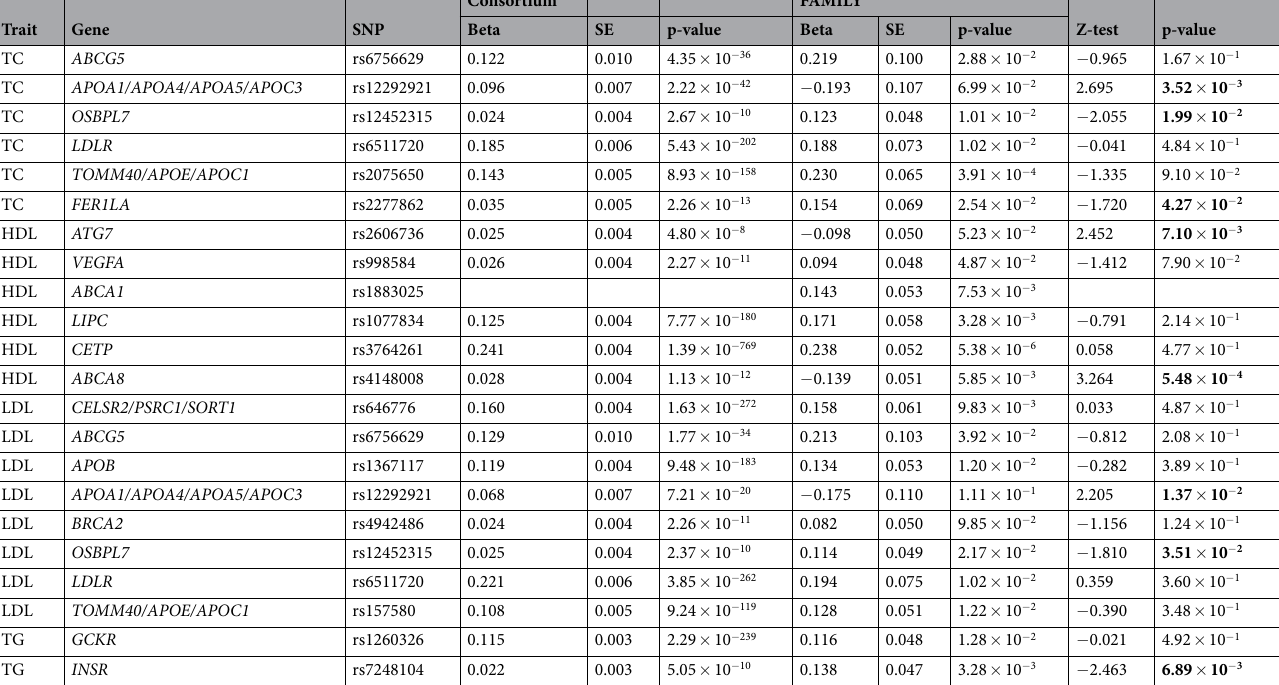
Table 4. Comparison of the statistically nominal significant SNP effects between children from FAMILY and adults from the Global Lipids Genetics Consortium. * The P-Values are for each child and adult SNP to show association effect in adults from the Global Lipids Genetics Consortium in comparison to children from FAMILY study. Beta and SE at birth, 3 year and 5 year are quartile normalization of the lipid level trait in mg/dl.